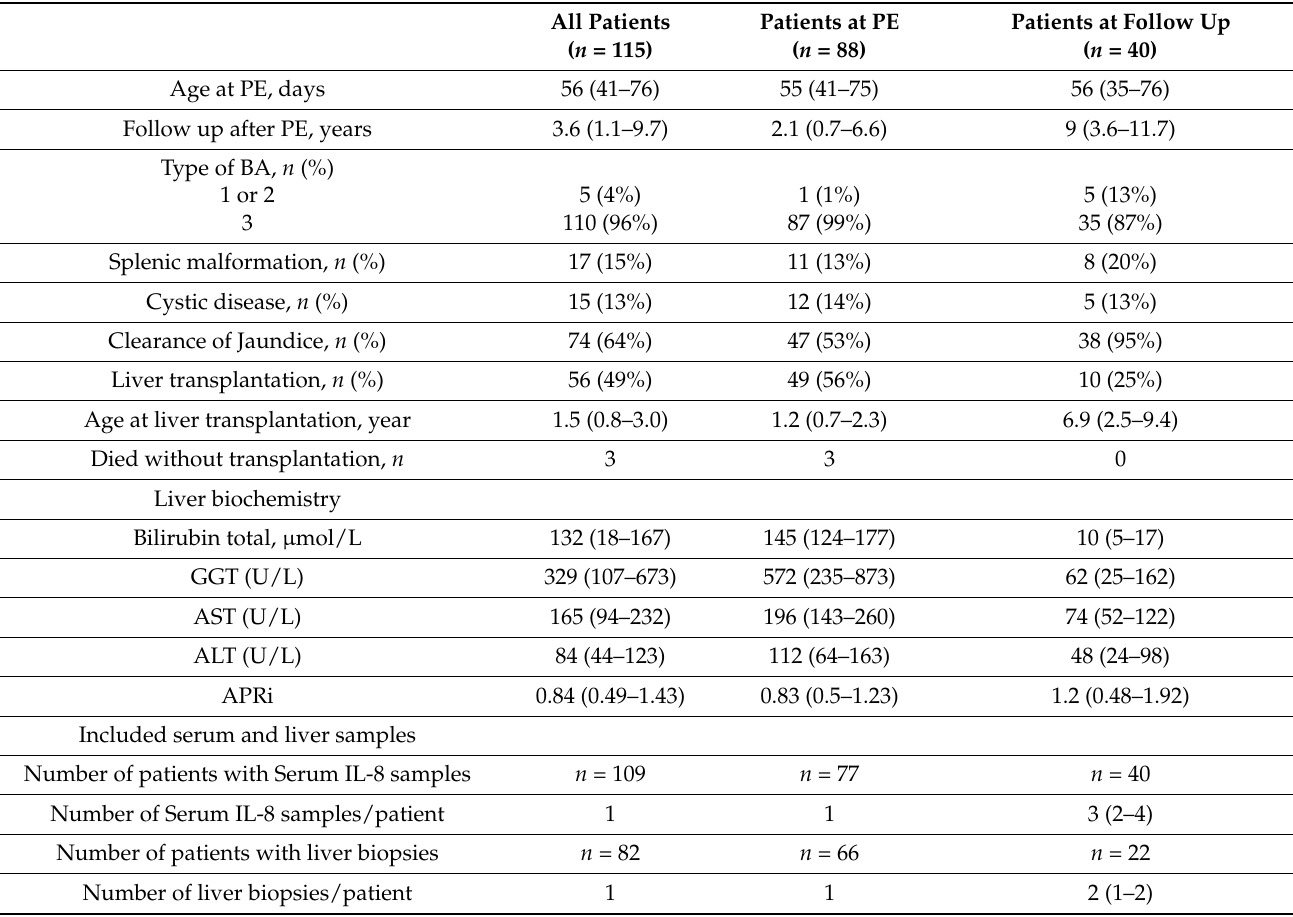
Table 1. Baseline patient characteristics and included study samples for all patients ( n = 115), this included patients with samples only at portoenterostomy (PE) ( n = 75) and patients with samples only at follow-up ( n = 27) as well as 13 patients with samples both at PE and follow-up. Data are median (interquartile range) or frequencies